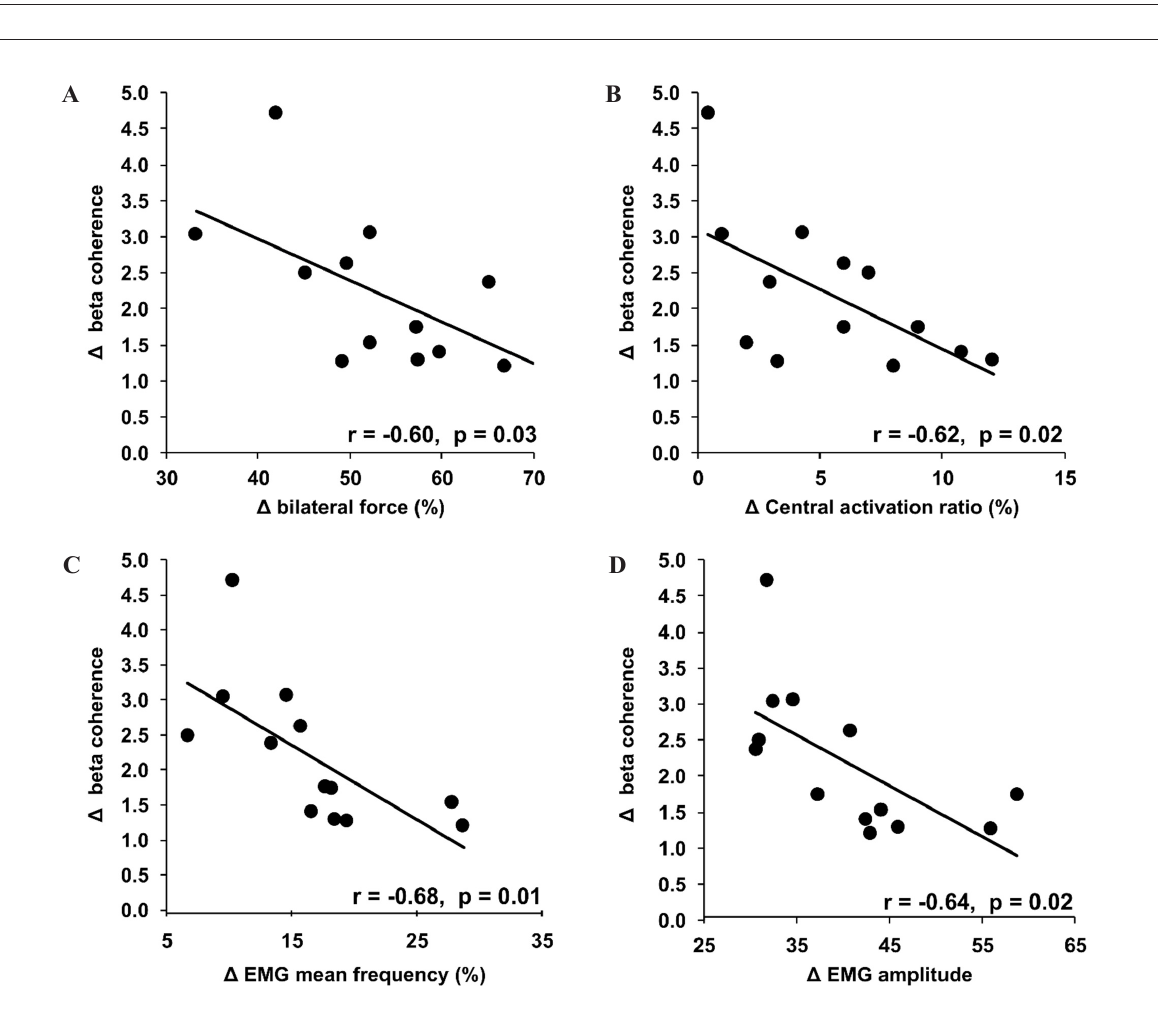
Figure 4 . Correlations between changes in EMG-EMG beta band (15-35Hz) coherence of Figure 4. Correlations between changes in EMG-EMG beta band (15-35Hz) coherence of homologous vastus lateralis muscles and changes homologous vastus lateralis muscles and changes in bilateral force (A), central activation in bilateral force (A), central activation ratio (B), EMG frequency (C) and EMG amplitude (D) ratio (B), EMG frequency (C) and EMG amplitude